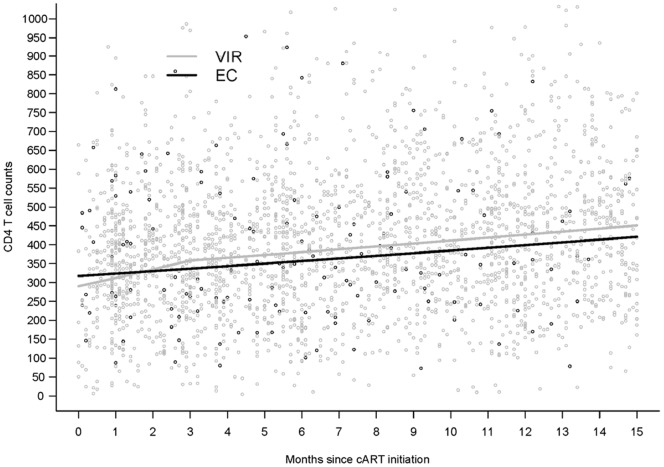
Estimated CD4 cell count dynamics in viremic patients (VIRs: n = 478) and elite controllers (ECs: n = 34) in mixed-effect linear models (mean CD4 T cells gain after 12 months of cART was significantly lower in ECs than in VIRs (p = 0.048)).